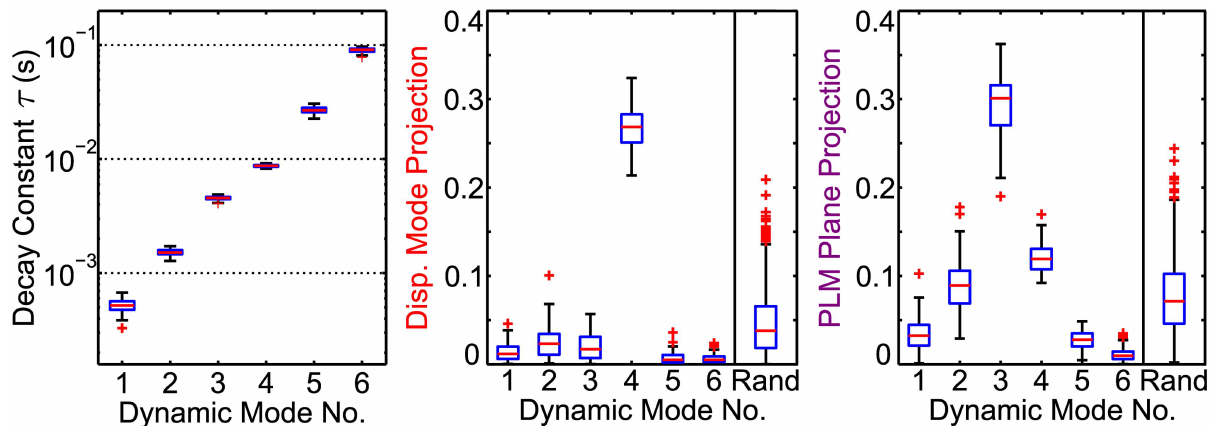
Fig 4. Two of the six dynamic mode clusters correspond to previously-discovered behavioral modes related to locomotion. DMD results from 100 random impulsetrials are plotted as box-and-whisker plots showingeach mode’s decay constant, as well as projections onto the displacement mode and PLM plane. Projectionsfrom 1000 randommodes are compared. Timescales of each mode are highly distinct and consistant, and vary over three overs of magnitude. Mode 4 and Mode 3 project strongly onto the Displacement Mode and PLM Plane, respectively.See Tables 1, 2 and 3 for corresponding numerical